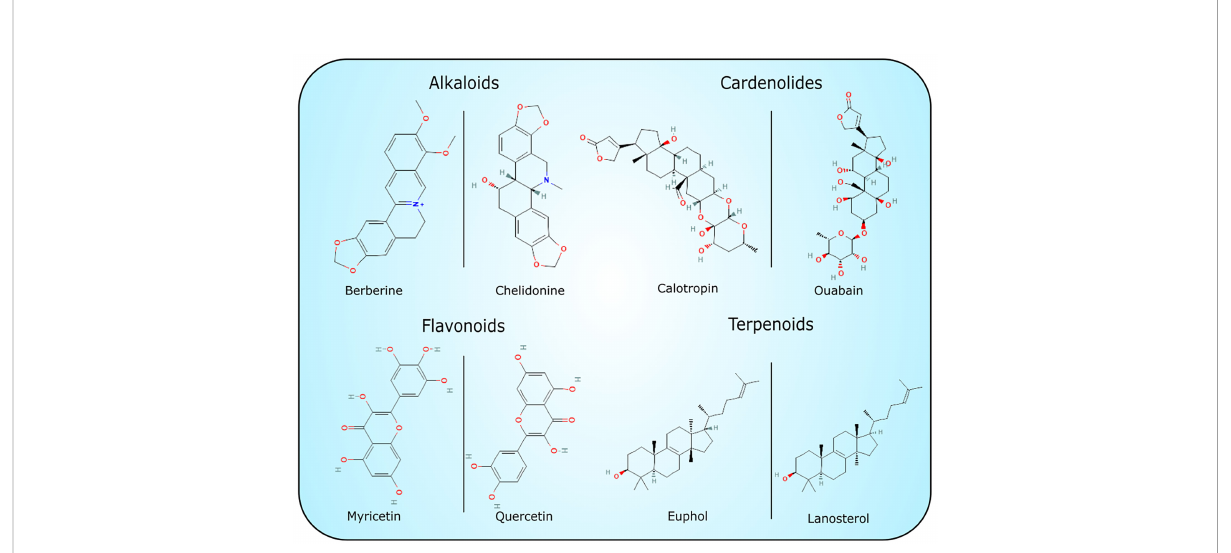
FIGURE 1 Chemical structures of selected low weight molecular compounds with potential cytotoxic